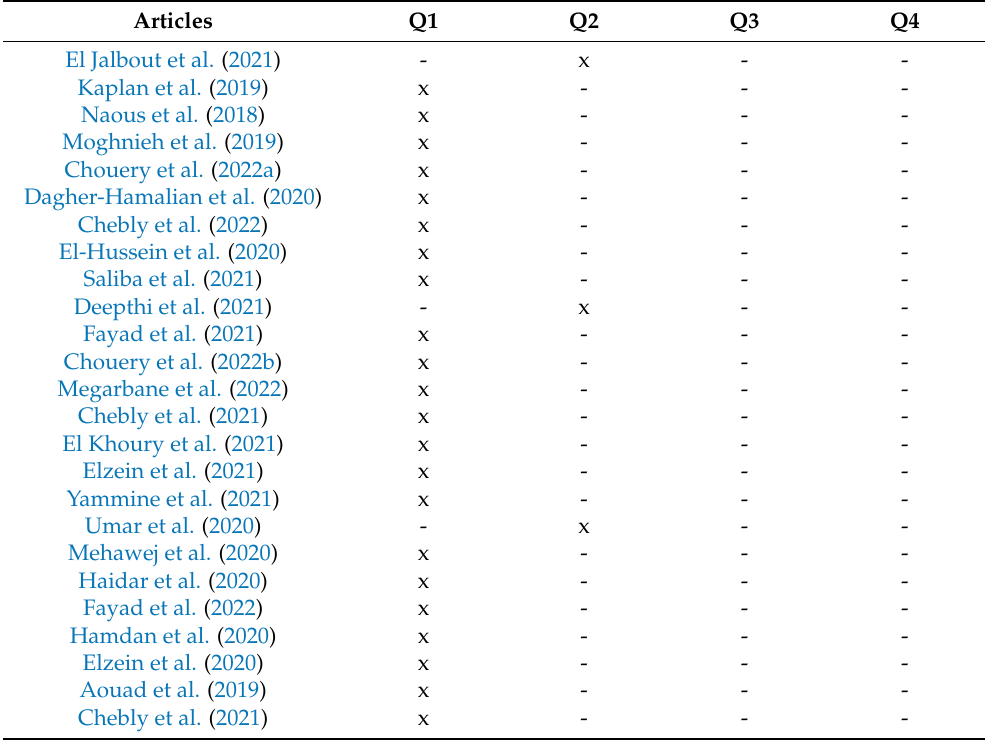
Table A5. Published papers in the School of Medicine per quartile, 2018–2022.